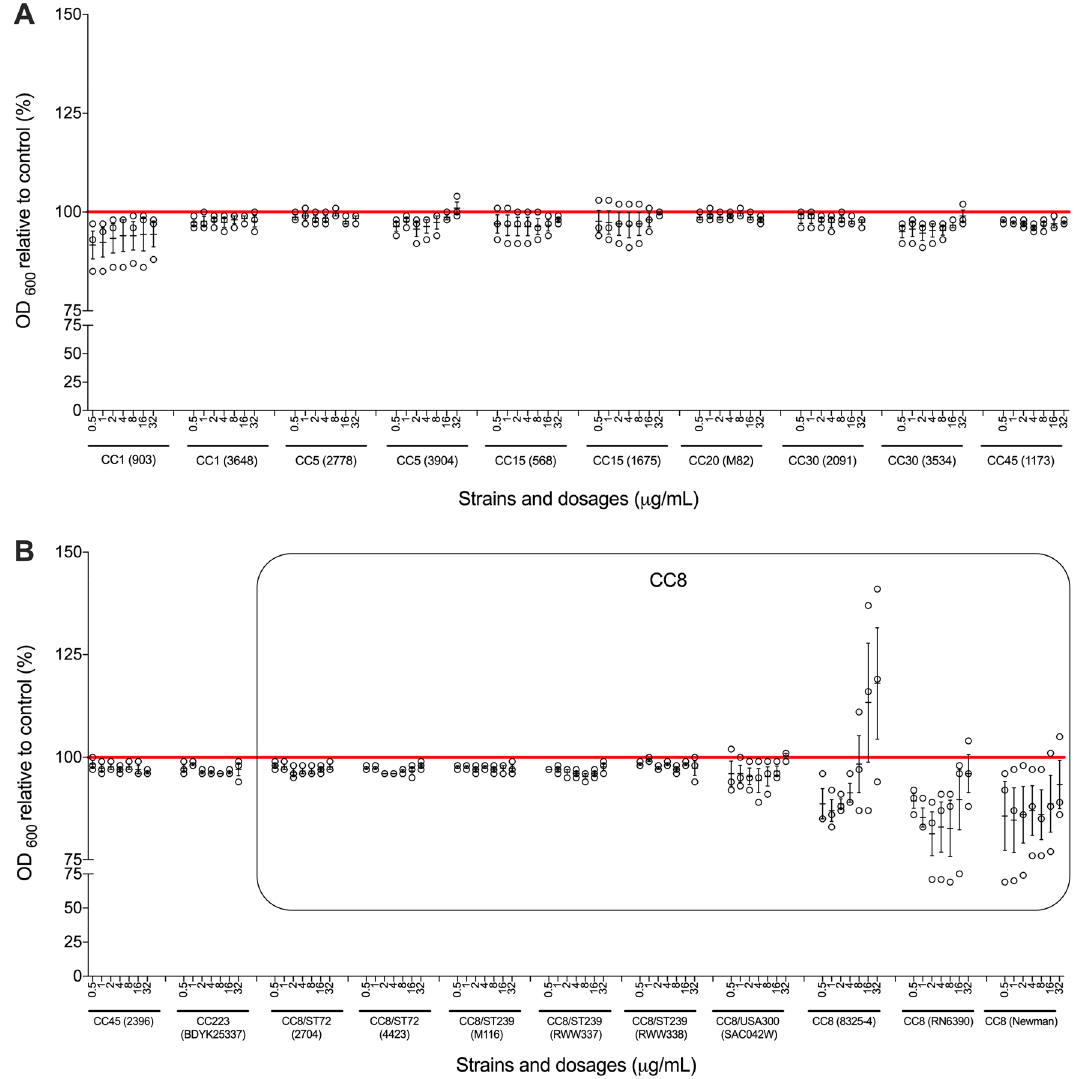
Figure 1. Broth microdilution assays with paracetamol. Broth microdilution susceptibility tests were performed on all study strains. ( A ) Strains with genetic backgrounds of CC1, CC5, CC15, CC20, CC30 and CC45. ( B ) Strains with genetic backgrounds of CC45, CC72, CC223 and CC8. The results are depicted as the percentage of paracetamol treated S. aureus MICs relative to its control (untreated). The red horizontal line represents the control. The black box outlines CC8 strains. Each black circle represents one experiment. Data points are presented with SEM of all three separate experiments performed for each